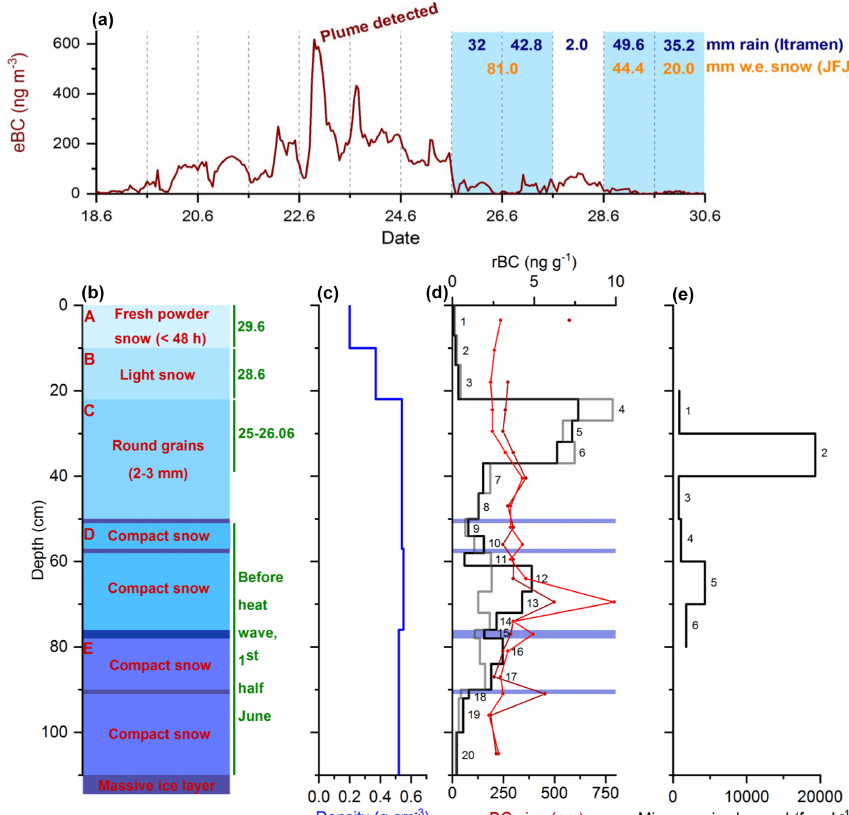
Figure 2. (a) Atmospheric-equivalent black carbon (eBC) concentrations at Jungfraujoch showing the peak on 22 June when the plume of smoke reached the site. A mass absorption coefficient of 10m 2 g − 1 was assumed. Blue bars indicate days with significant snowfall at JFJ, with a comparison between the daily precipitation amount measured at Itramen (values in blue in millimetres; data from SLF © 2019) and the daily snowfall height inferred from the snow pit at JFJ, corrected for density (values in orange in millimetres of water equivalent, w.e.). (b) Snow pit stratigraphy with ice lenses in dark blue. (c) Density profile of the snow pit. (d) The rBC concentration profile (top scale) with the two series of replicates (black and grey) and associated sample number. Mode of the rBC mass size distribution (bottom scale) with the two series of replicates (dark red and red). Blue bars are ice lenses. (e) Microscopic charcoal concentration